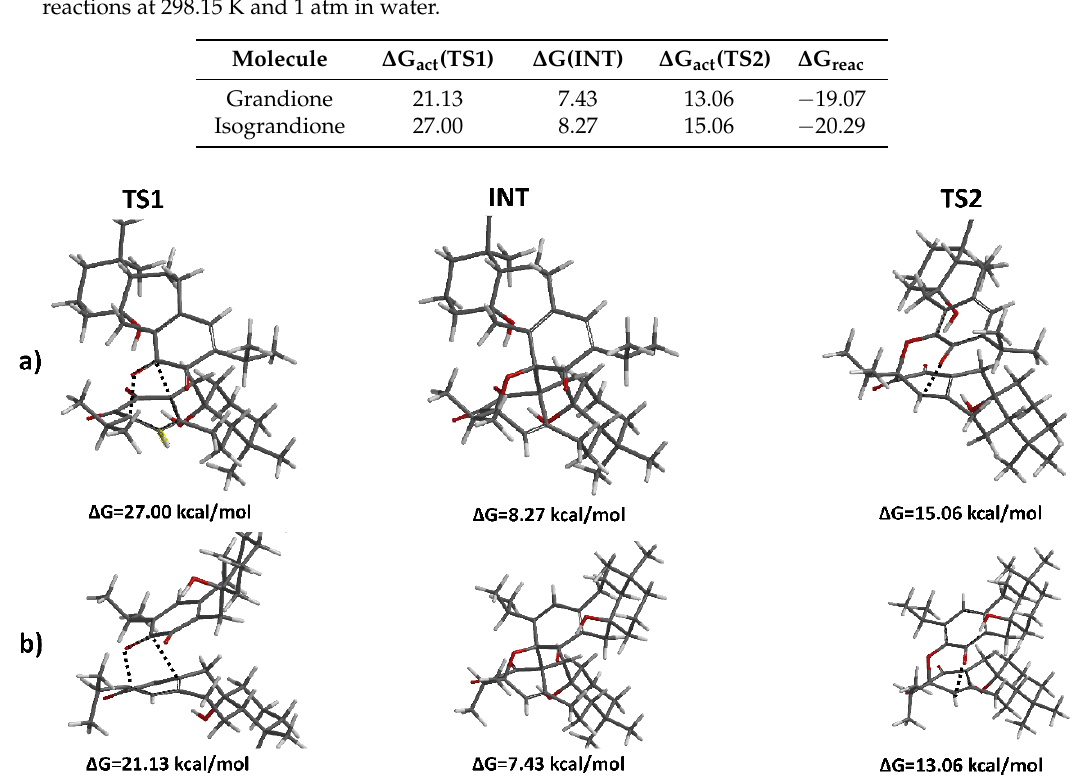
Figure 3. Equilibrium geometries of intermediaries and transition states and their relative energies for the domino process to lead to ( a ) the isograndione and ( b ) grandione molecules. Table 2. Relative energy Gibbs reactions (kcal/mol) for the stationary points involved in the Tandem reactions at 298.15 K and 1 atm in water.